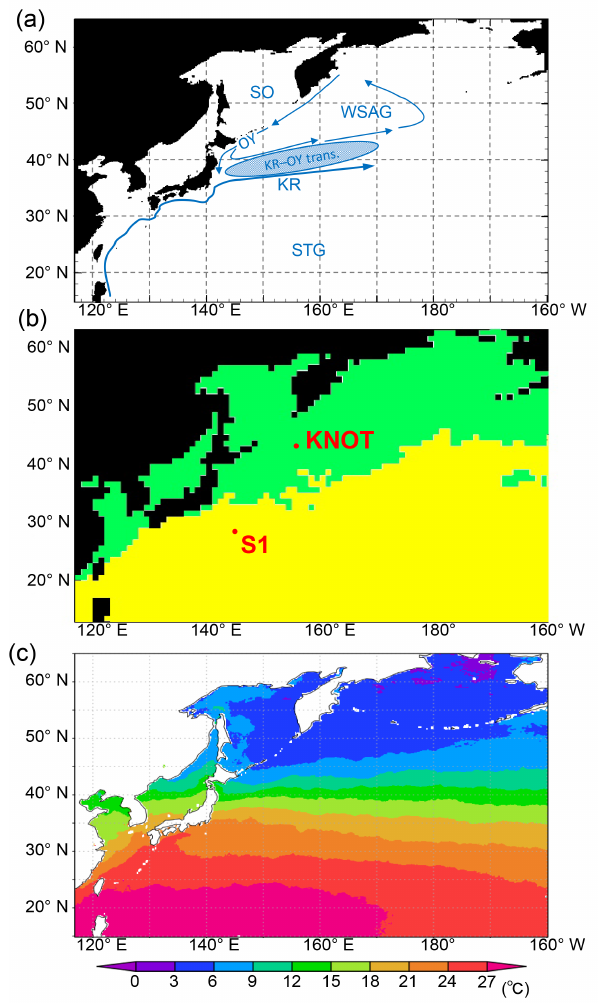
Figure 1. (a) Model domain in the WNP region of the 3-D NSI- MEM. Blue arrows and symbols depict a schematic representation of the main circulation features in the WNP (KR: Kuroshio; OY: Oyashio; KR-OY trans.: the Kuroshio–Oyashio transition region; STG: Subtropical Gyre region; WSAG: Western Subarctic Gyre; and SO: the Sea of Okhotsk). (b) Two classified provinces (subarc- tic and subtropical regions) based on the dominant phytoplankton species and nutrient limitations by Hashioka et al. (2018). Different ecosystem parameters (Table 2) are set for each province in the sim- ulation. (c) Annual mean SST of satellite data used for simulation of SST-dependent physiological parameters (SST-dependent